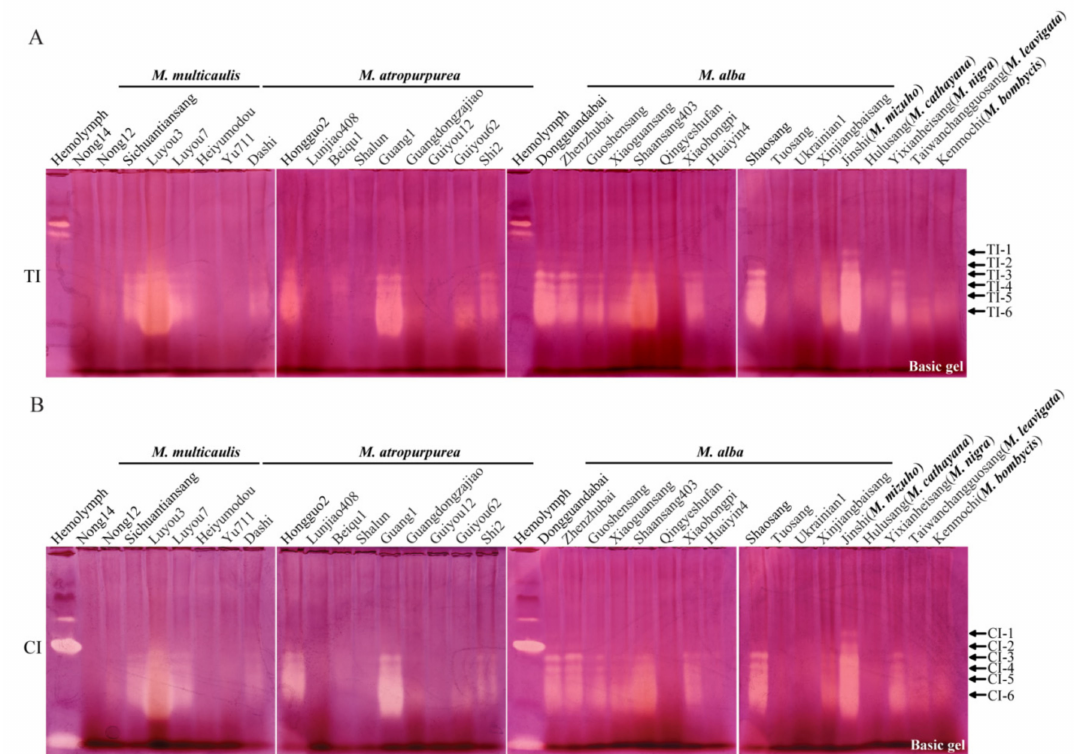
Figure 2. Activity staining of TIs ( A ) and CIs ( B ) from leaves of different mulberry varieties. “Basic gel” indicates Native PAGE under alkaline conditions. “TI” and “CI” represent trypsin inhibitor and chymotrypsin inhibitor, respectively. B. mori hemolymph from day-5 fifth-instar larvae was used as positive control. From left to right, varieties from “Nong14” to “Yu711” belong to M. multicaulis ; varieties from “Dashi” to “Shi2” belong to M. atropurpurea ; varieties from “Dongguangdabai” to “Xinjiangbaisang” belong to M. alba . The last five mulberry varieties belong to M. mizuho , M. cathayana , M. nigra , M. leavigata and M. bombycis , respectively. The arrows show activity-stained bands of trypsin inhibitors and chymotrypsin inhibitors, which are named “TI-1~TI-6” and “CI-1~CI-6” from top to